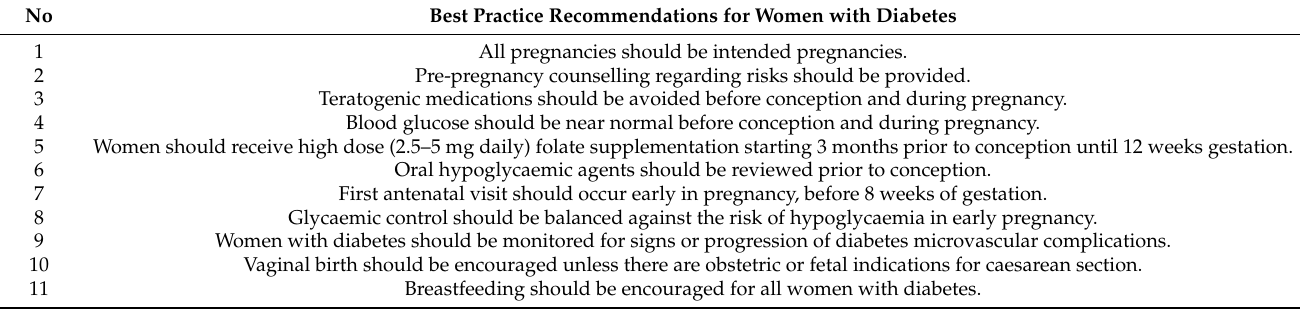
Table 1. ADIPS key recommendations that were audited for women with diabetes [17].